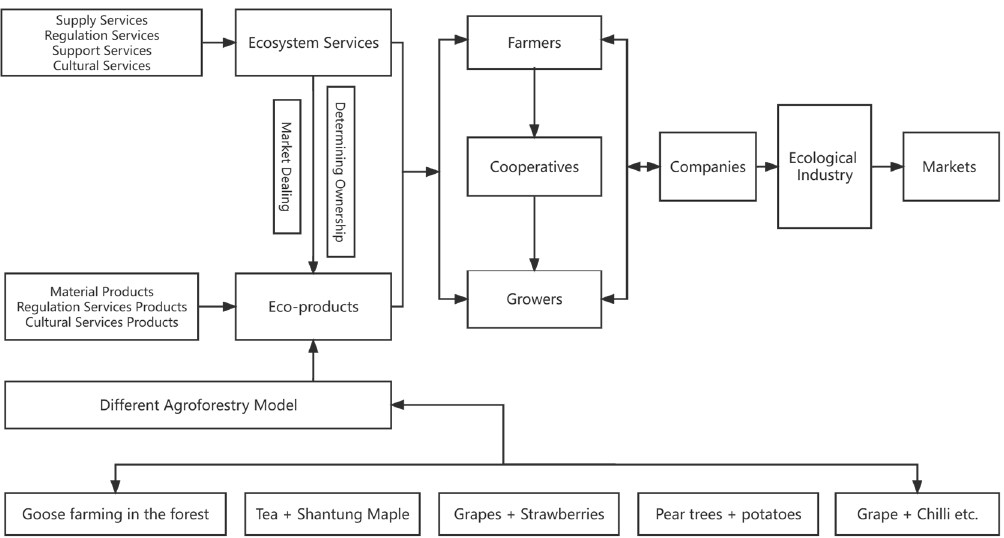
Figure 6. Ecological processes in the formation of eco-industries in different agroforestries.